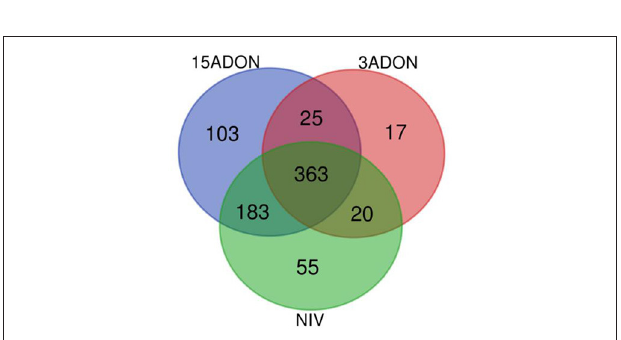
FIGURE 6 | A Venn diagram of enriched categories of GO terms (FDR ≥ 0.05) associated with differentially expressed genes in additive generalized linear model (GLM) contrast of mock control and Fusarium treatment (3ADON, 15ADON, and NIV